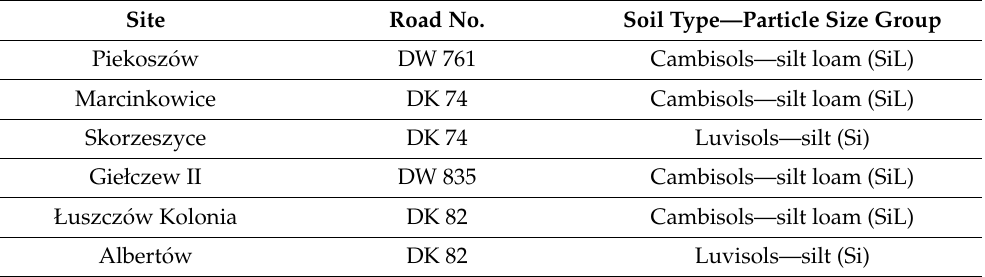
Table 1. Area inventory, location, soil types, and